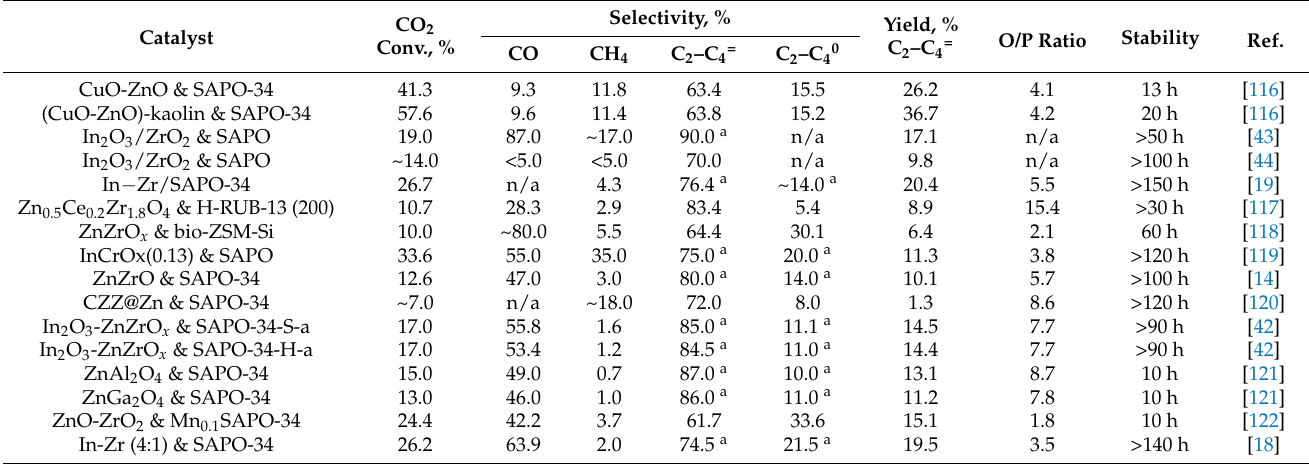
Stability Ref. C 2 –C 4=